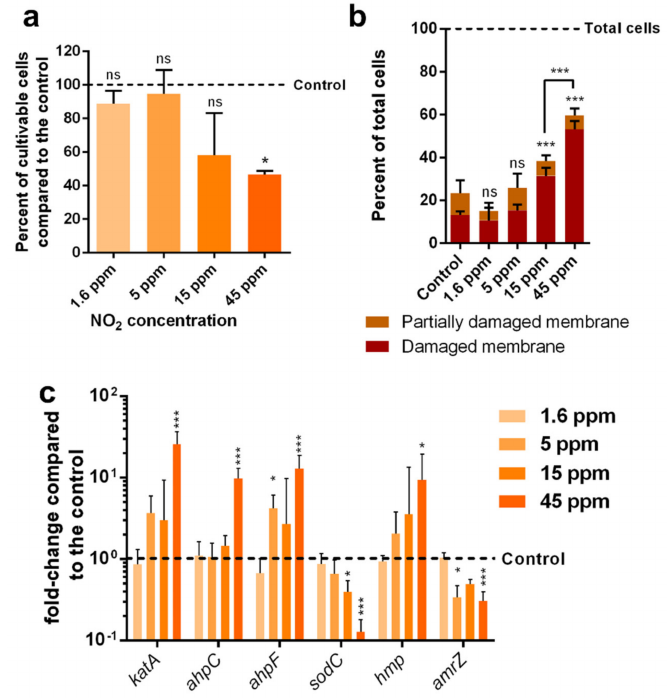
Figure 4. Physiological modifications of P. fluorescens MFAF76a after exposure to various concentra- tions of NO 2 . ( a ) Cultivability of bacteria after exposure to NO 2 compared to cells exposed to synthetic air. ( b ) Membrane integrity assessed by live-dead flow cytometry assays using Live/Dead BacLight kit (L-7012, ThermoFisher) according to the manufacturer’s recommendations. ( c ) Expression of genes coding for proteins involved in RNS and ROS detoxification. Graphs represent means ± SEM. ns = p > 0.05; * = p < 0.05; *** = p < 0.001, N ≥ 3.